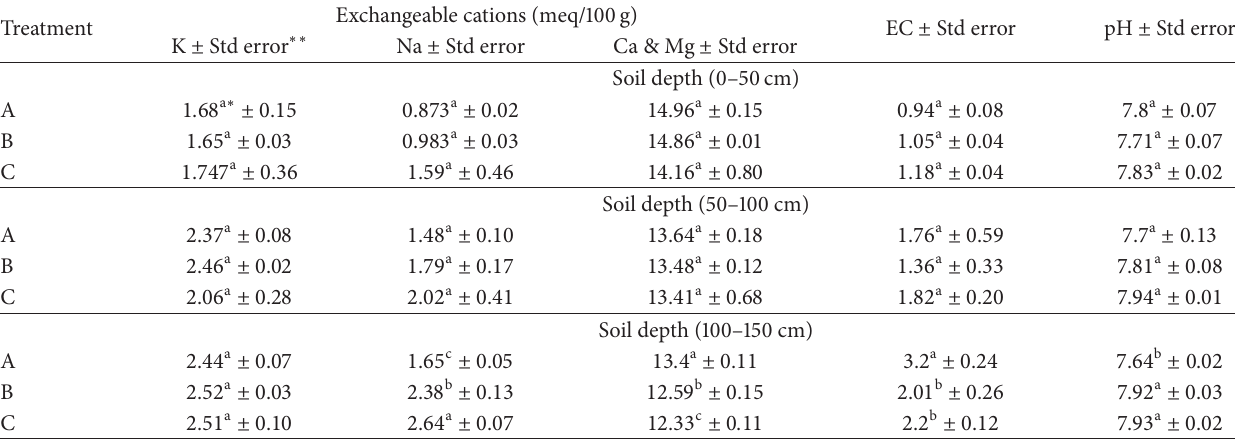
Table 2: Exchangeable cation concentrations (meq/100g soil), electrical conductivity (dS/cm), and pH of saturated soil paste extract after the leaching